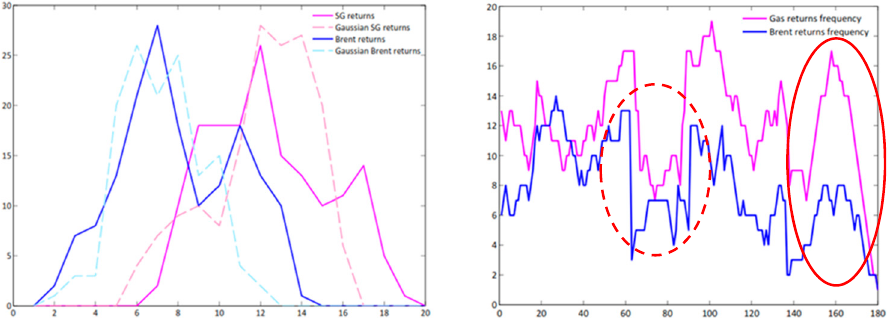
Figure 3. Clustering distribution ( left ) and SG vs. Brent frequency ( right ).